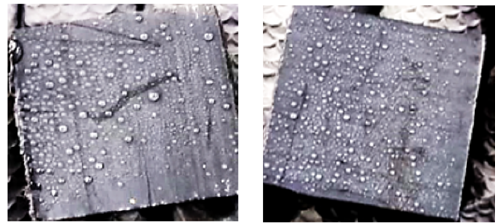
Figure 4. Camera image of Teflon surface for non-ESD ( left ) and ESD ( right